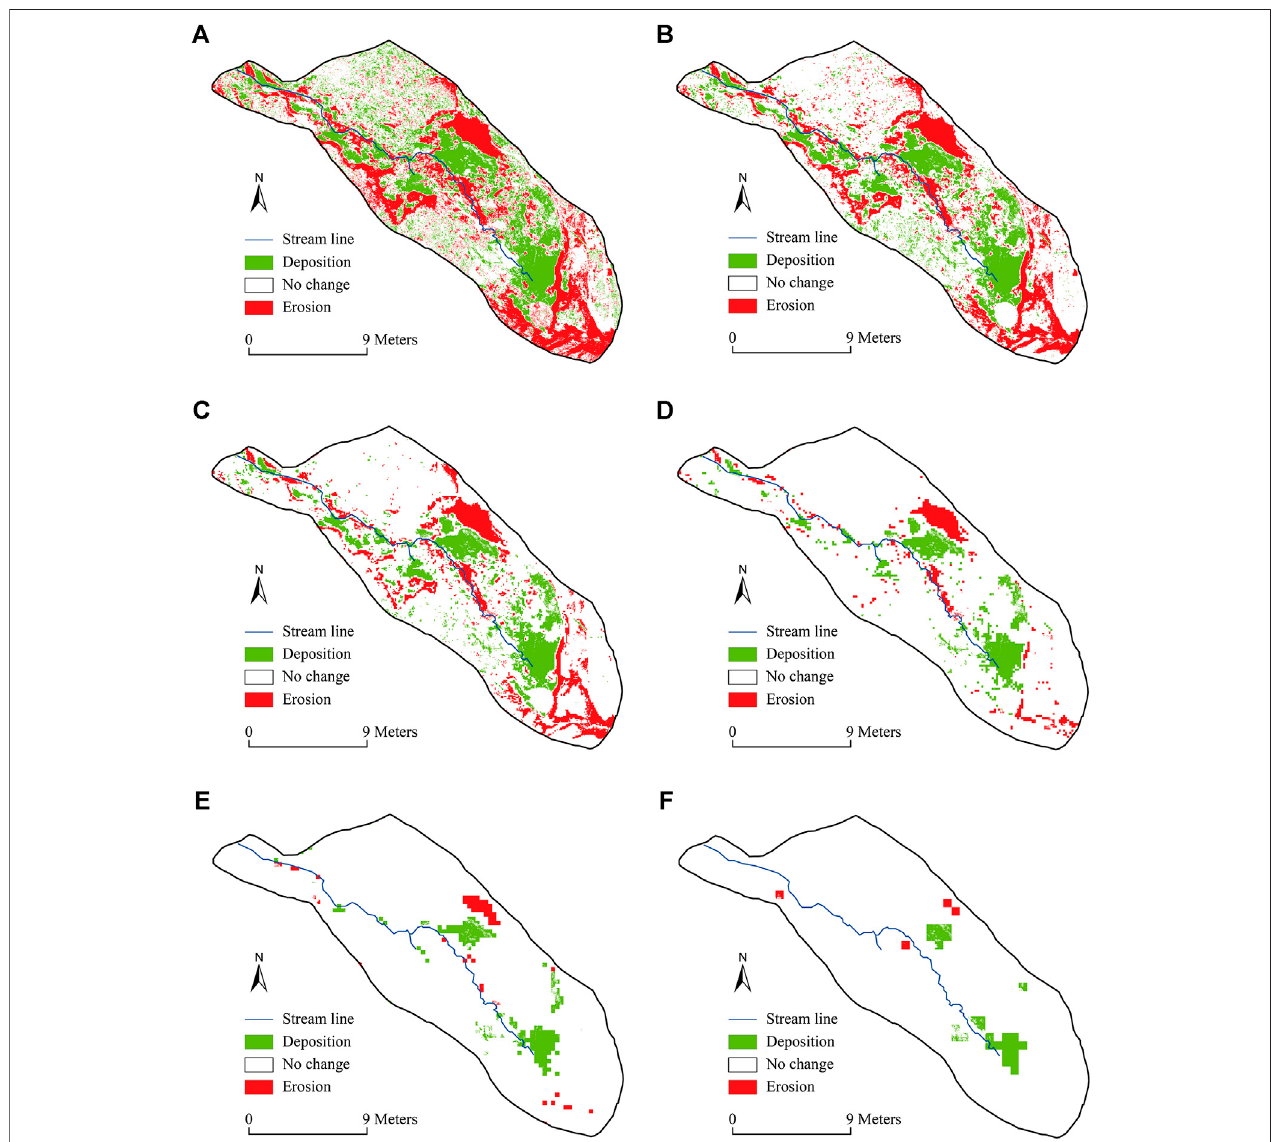
FIGURE5| Spatial distributionofthe erosionand deposition spotsbased onthe DoD analysisfordifferentDEM resolutions: (A) 2-cm, (B) 4-cm, (C) 8-cm, (D) 16- cm, (E) 32-cm, and (F) 64-cm.